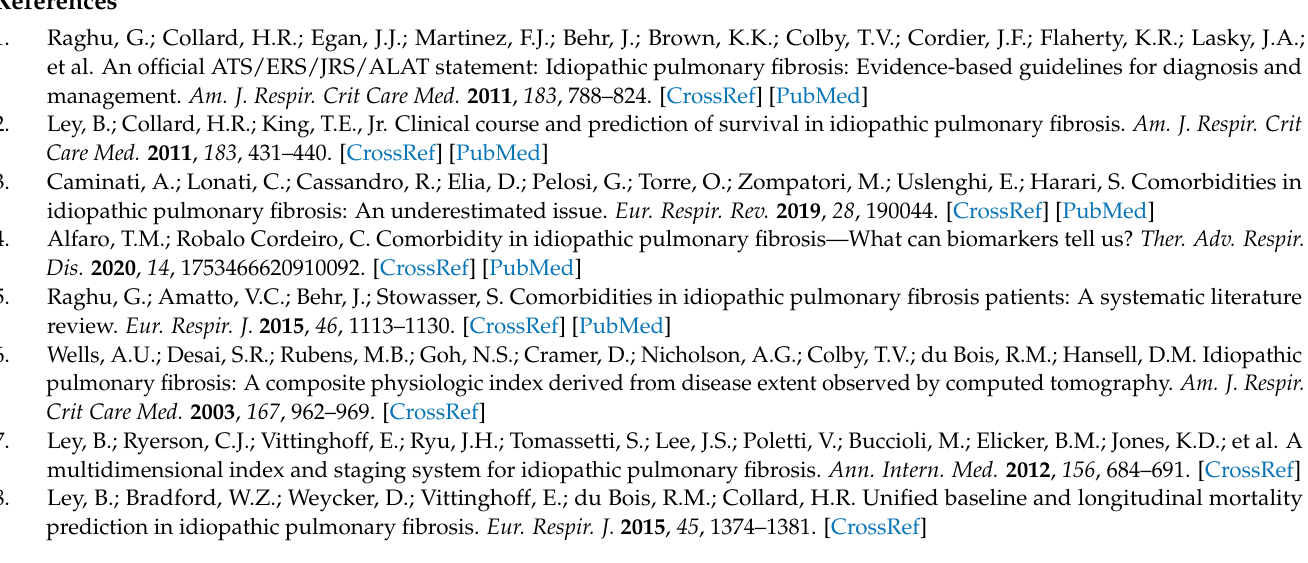
Table S2: PRISMA 2020 manuscript